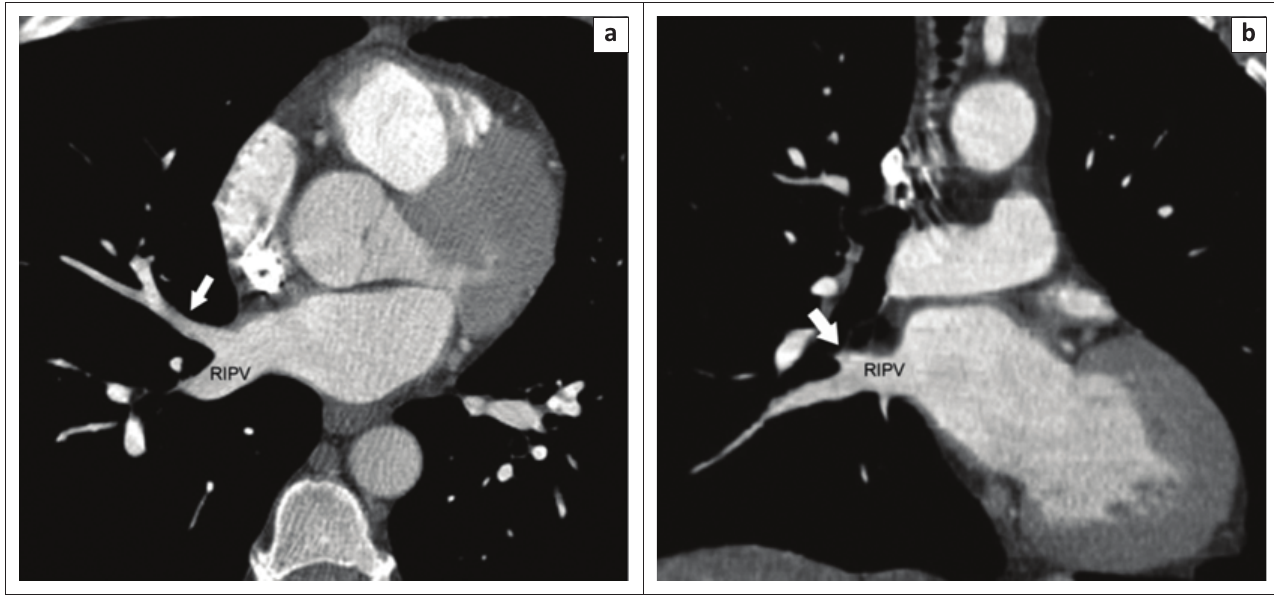
RIPV, right inferior pulmonary vein. FIGURE 3: The (a) middle lobe pulmonary vein (arrow) draining directly into the right inferior pulmonary vein; (b) multiplanar